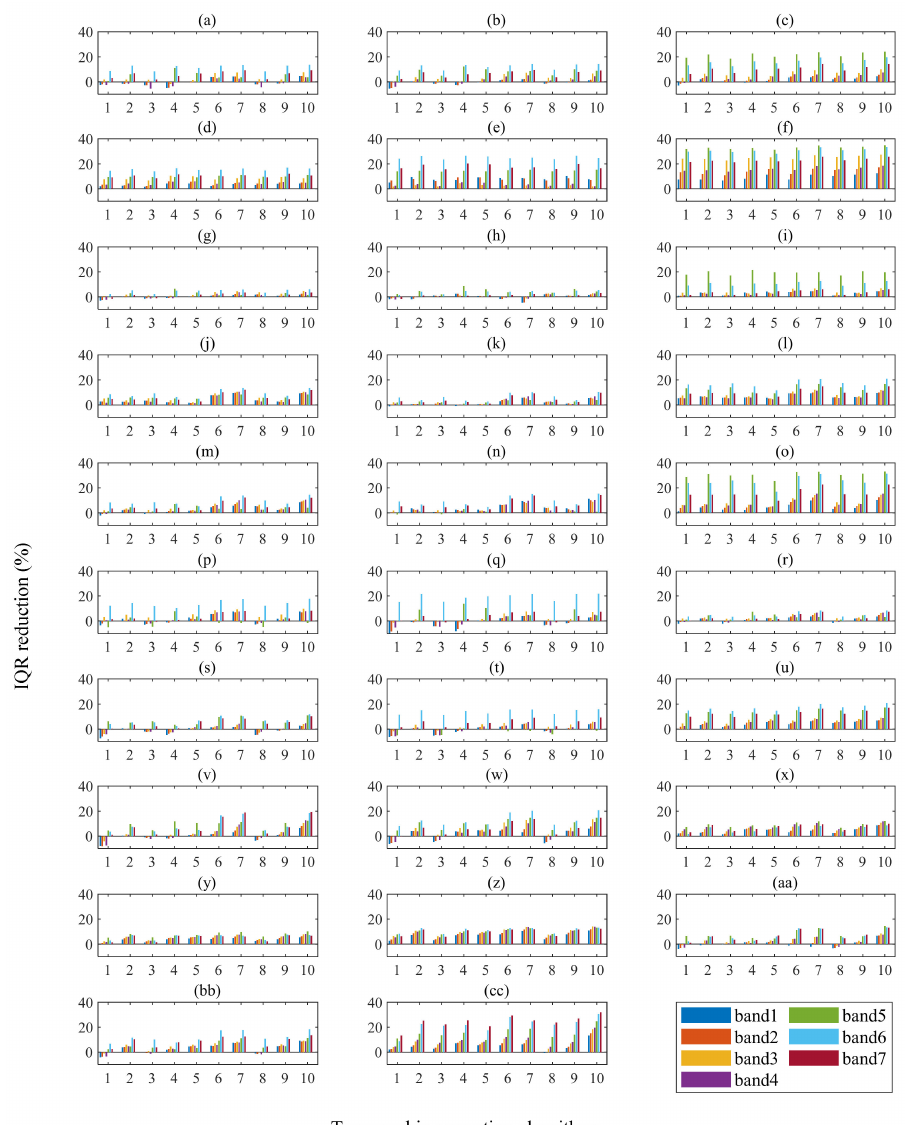
Figure 6. The comparison of IQR reduction in May/July/September. The x label’s number represents different algorithms: b correction, SCS+C, C, Minnaert+SCS, PLC, VECA, Teillet regression, C with land type stratification, SCS+C with land type stratification, and Teillet regression with land type stratification. ( a ) 120,039 (path/row) image obtained on 20170518, ( b ) 120,039 image obtained on 20170721, ( c ) 120,039 image obtained on 20160920, ( d ) 121,024 image obtained on 20180528, ( e ) 121,024 image obtained on 20160725, ( f ) 121,024 image obtained on 20180917, ( g ) 121,042 image obtained on 20170509, ( h ) 121,042 image obtained on 20170728, ( i ) 121,042 image obtained on 20160927, ( j ) 122,035 image obtained on 20180503, ( k ) 122,035 image obtained on 20170703, ( l ) 122,035 image obtained on 20180908, ( m ) 124,032 image obtained on 20170514, ( n ) 124,032 image obtained on 20170712, ( o ) 124,032 image obtained on 20180922, ( p ) 128,036 image obtained on 20180513, ( q ) 128,036 image obtained on 20150724, ( r ) 129,043 image obtained on 20170501, ( s ) 131,035 image obtained on 20180502, ( t ) 131,035 image obtained on 20180721, ( u ) 131,035 image obtained on 20180923, ( v ) 131,038 image obtained on 20160512, ( w ) 131,038 image obtained on 20160715, ( x ) 139,040 image obtained on 20170507, ( y ) 139,040 image obtained on 20150721, ( z ) 139,040 image obtained on 20150907, ( aa ) 143,030 image obtained on 20180522, ( bb ) 143,030 image obtained on 20170722, ( cc ) 143,030 image obtained on